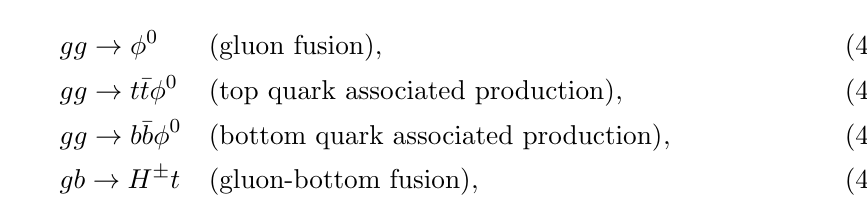
Figure 4 . Cross section for gg ! (cid:30) 0 (left) and gg ! b (cid:22) b(cid:30) 0 (right) at